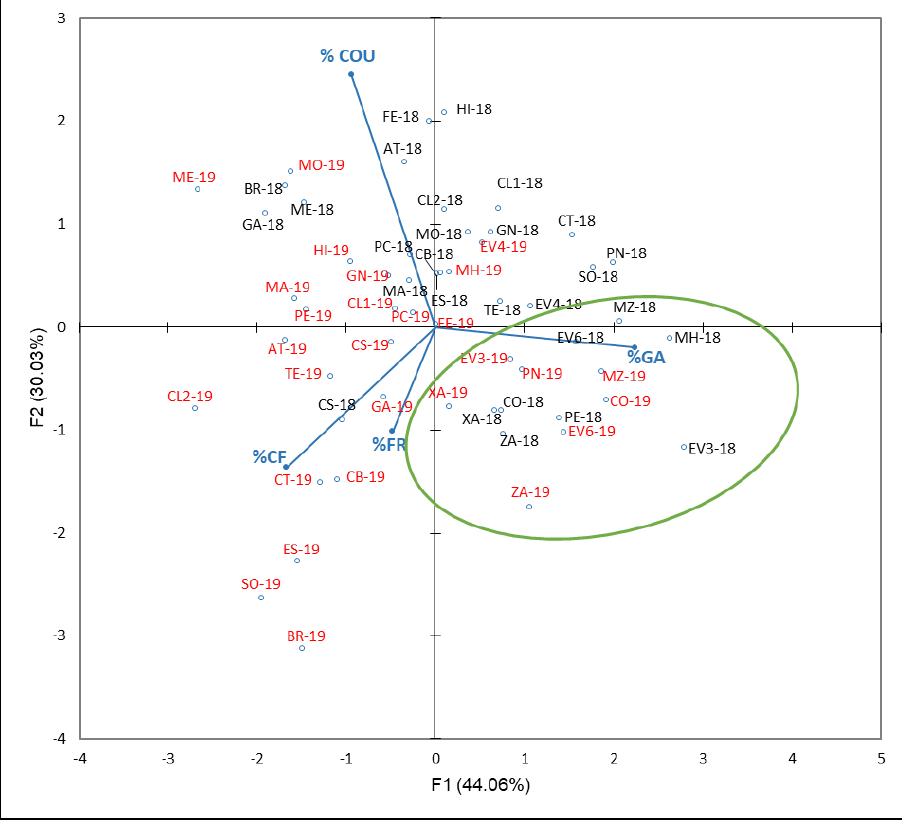
Figure 8. Principal component analysis on phenolic acids compounds profile (percentage) of grapes from the EVEGA germplasm bank in 2018 and 2019 vintages. % CF, % COU, % GA, and % FR are percentages of caffeic acid, coutaric acid, gallic acid, and ferulic acid, respectively. Data for the black and red varieties reflect the data for 2018 and 2019 harvests respectively. See Table 1 for varieties abbreviations.